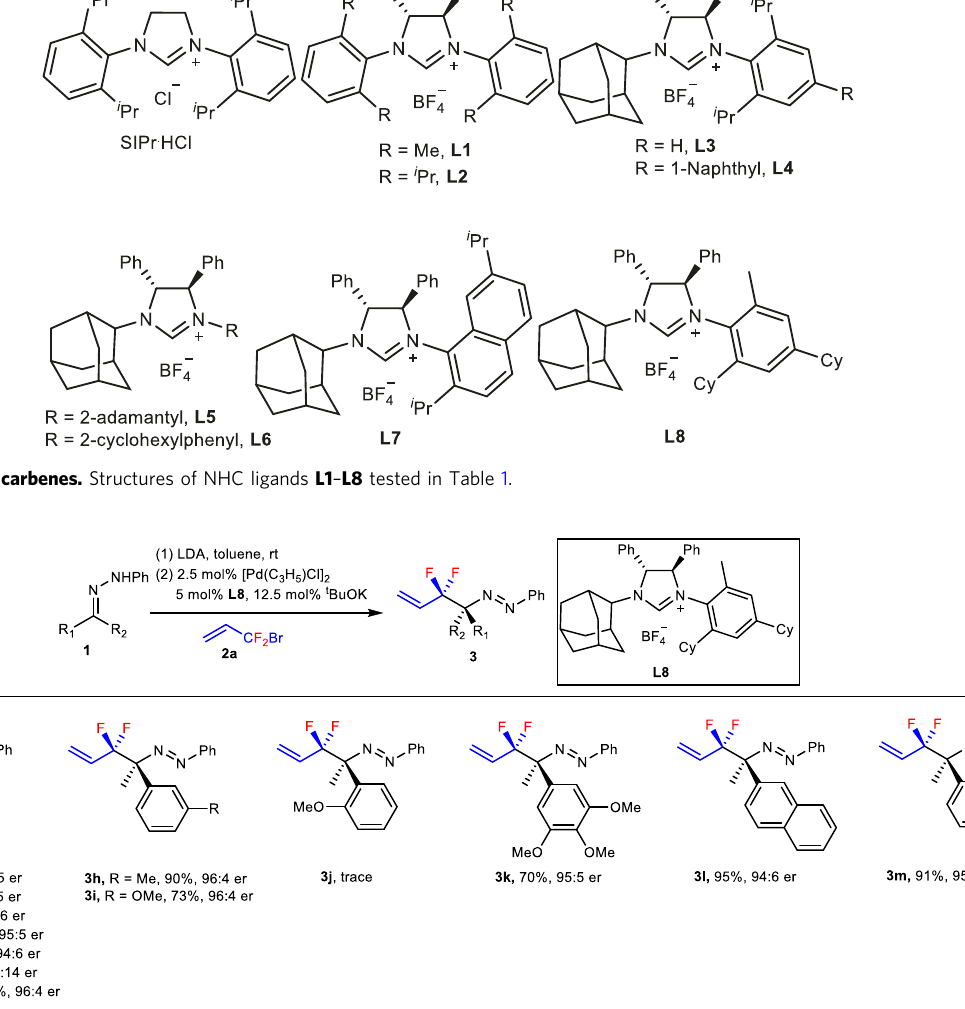
NATURE COMMUNICATIONS| (2021) 12:6551